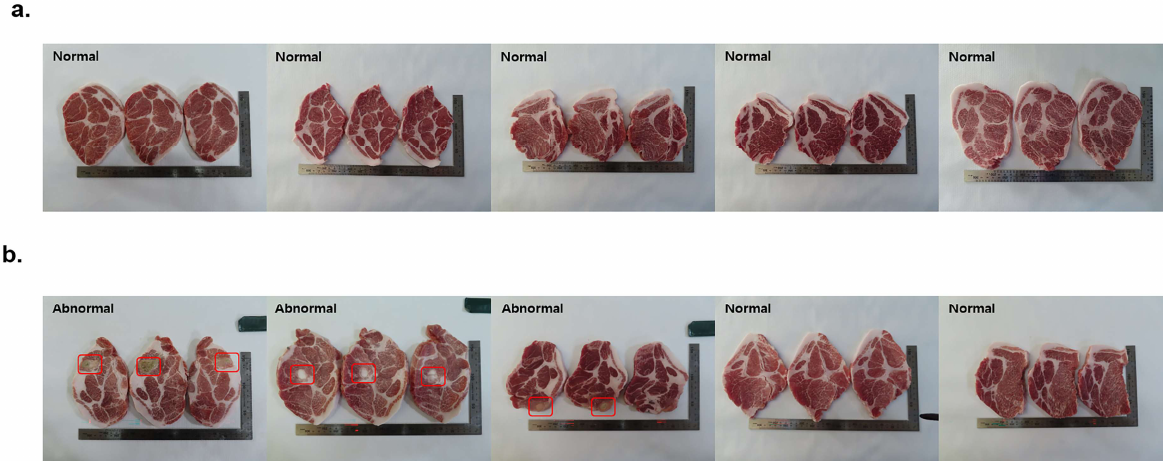
Figure 6. Pathologic lesion of an injection site following administration of the ID and IM bivalent vaccine (O PA-2 + A22 Iraq). After vaccination of five swine with ID and IM bivalent vaccine, the pathologic lesion of injection sites was checked. ( a ) The ID vaccination group; ( b ) The IM vaccination group (The marked red boxes are the part of the side effects.).